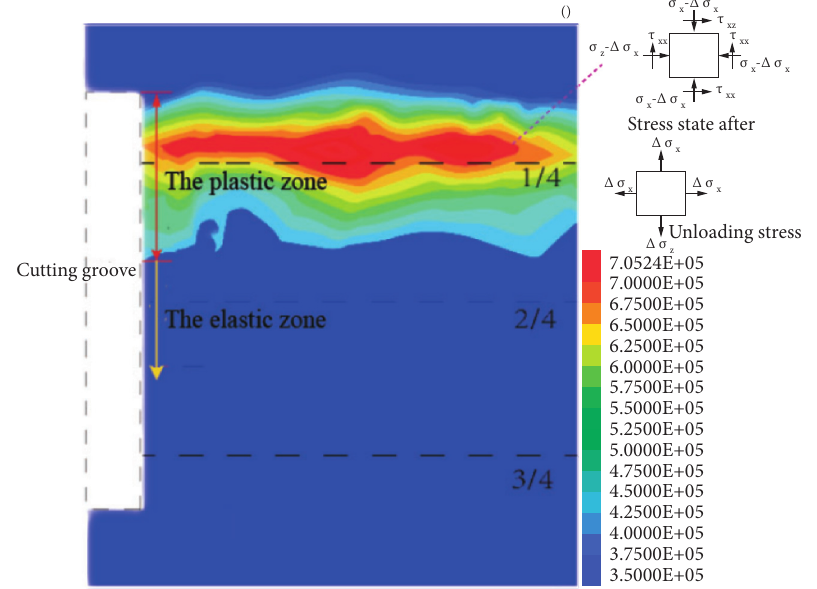
Figure 5: Energy distribution nephogram of the unloading profile of pillar excavation